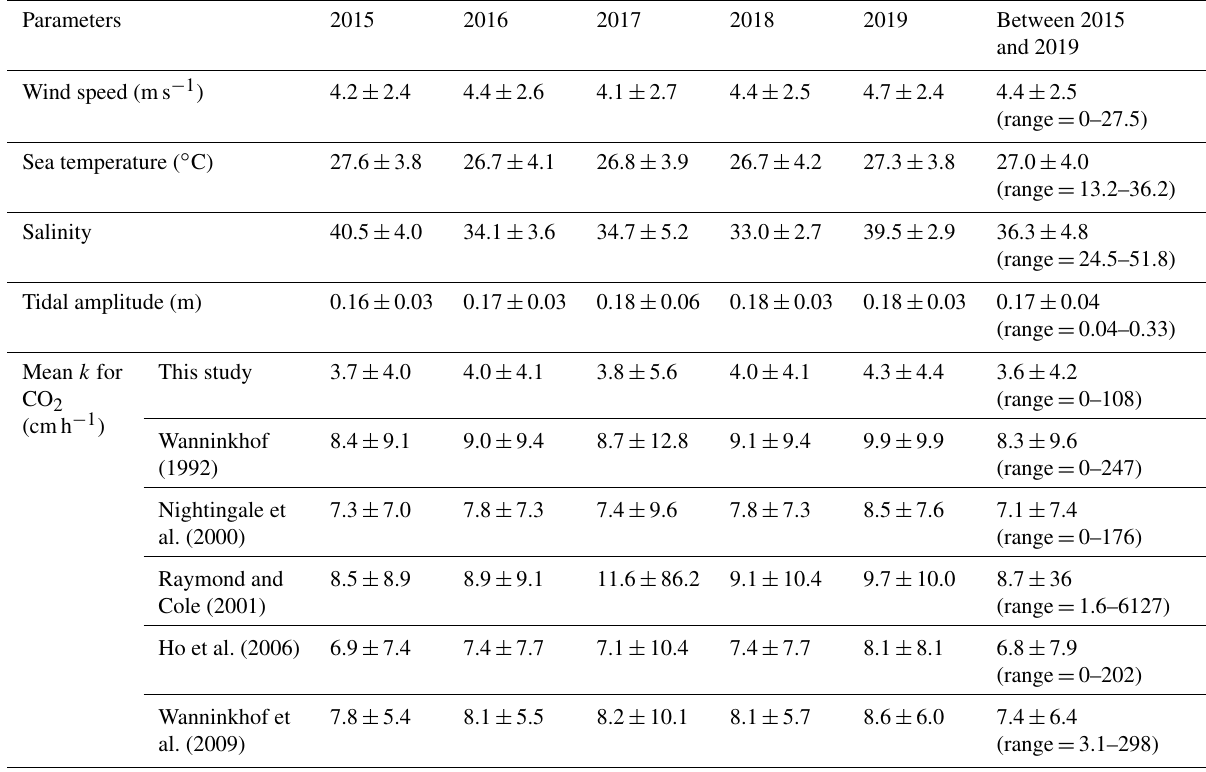
Table 3. Gas transfer velocities of CO 2 at in situ temperature and salinity in Florida Bay between 2015 and 2019 calculated using the wind speed/gas exchange parameterization determined here and from published